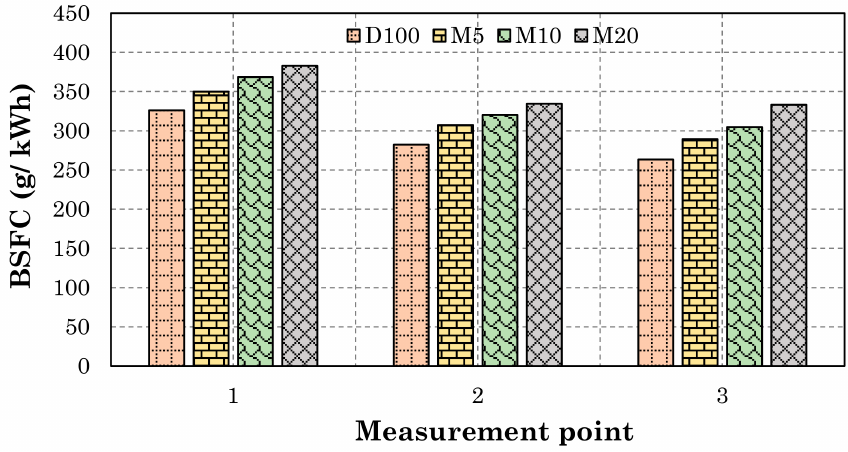
Figure 7. Brake-specific fuel consumption of all test fuels at the measurement